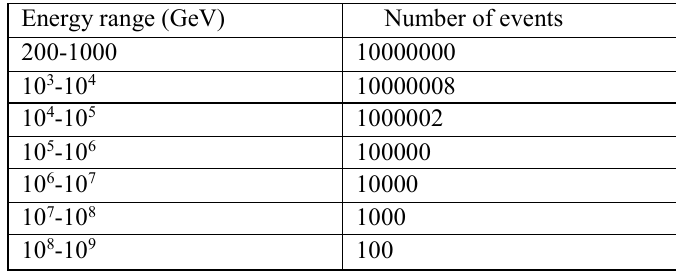
Table 1: Number of simulated events for each energy range in the first